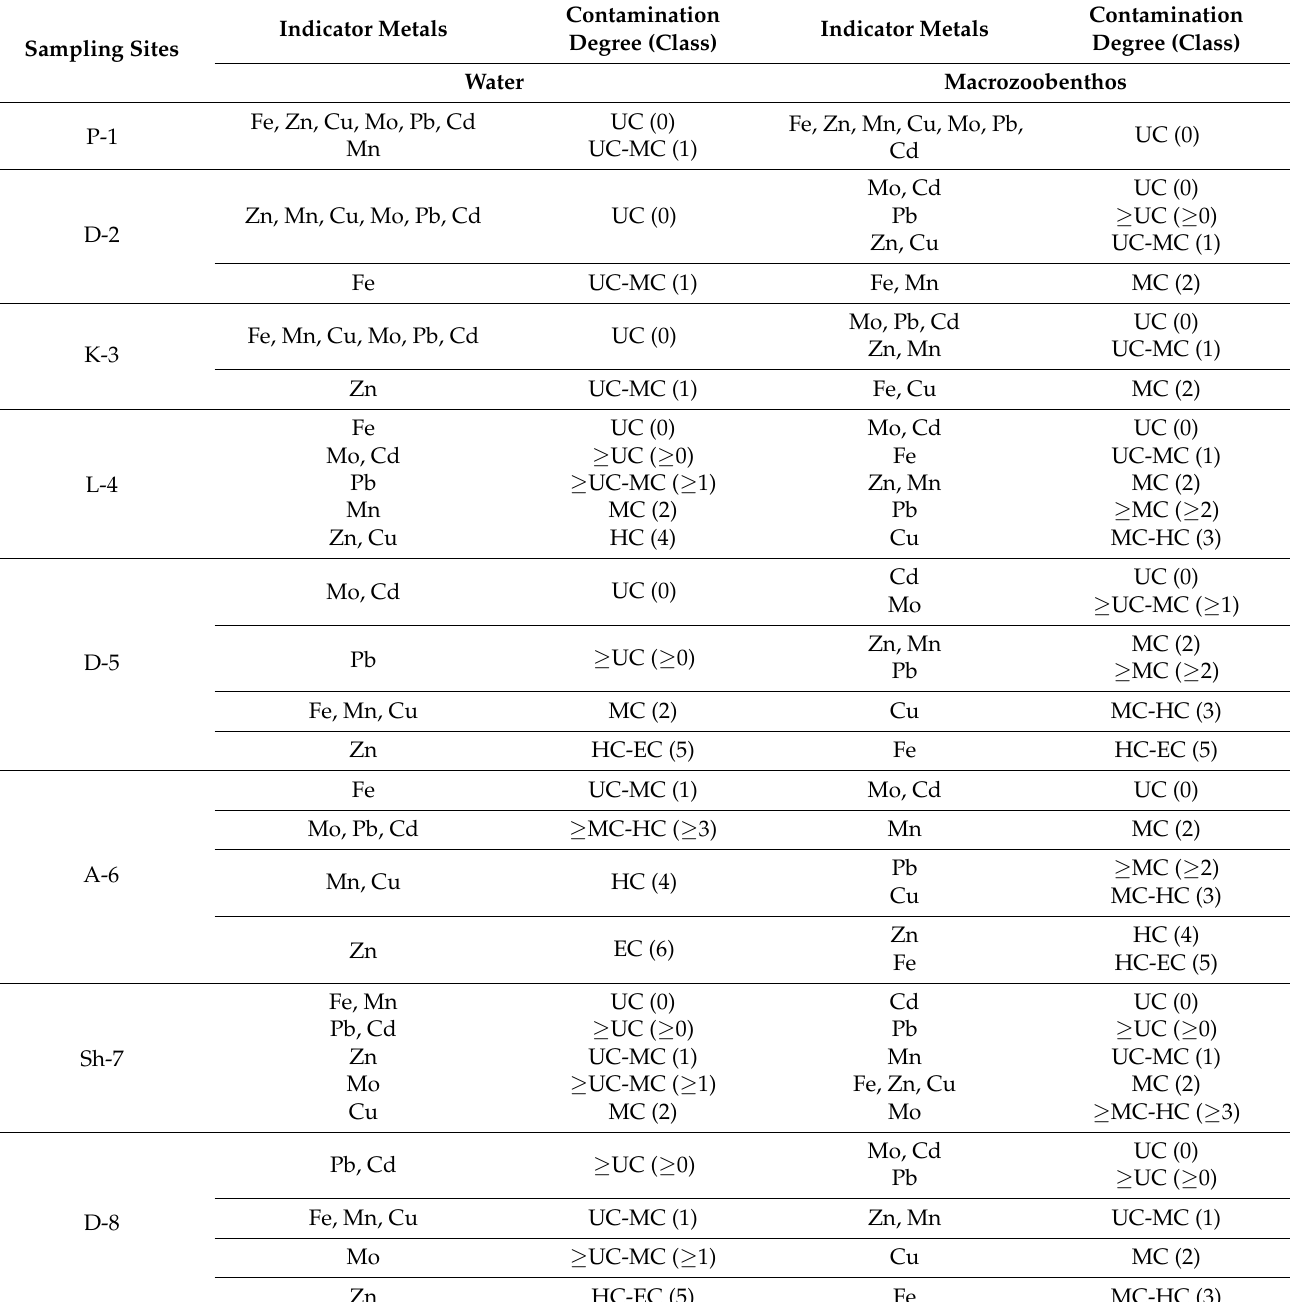
Table 6. HM contamination degrees in the river waters and macrozoobenthos of the Debed catchment